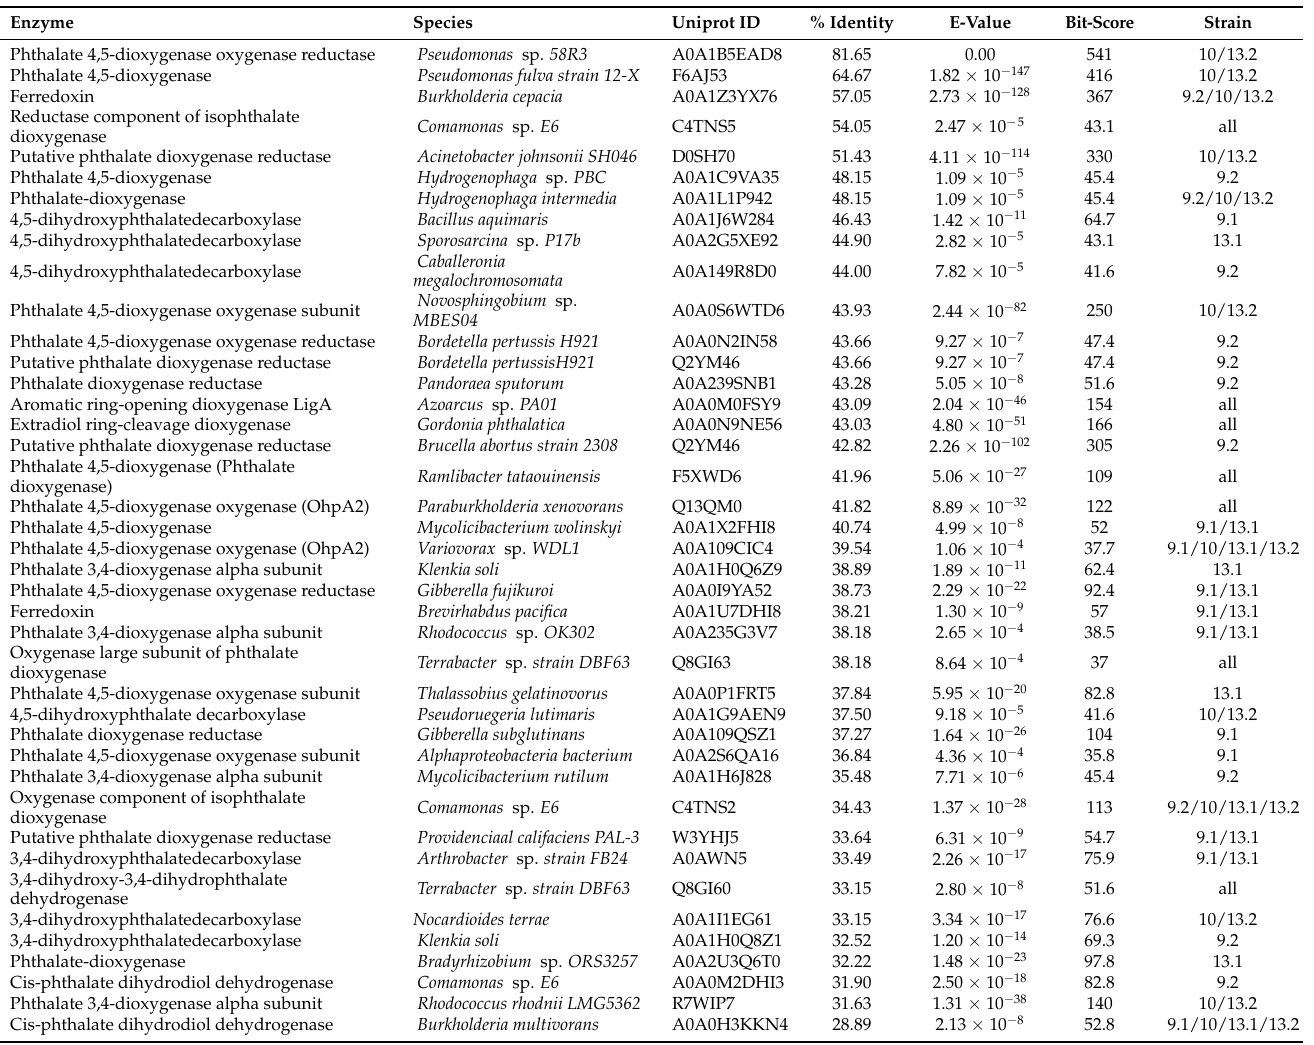
Table 3. Predicted phthalate plasticizer biodegradation genes with significant percentage identity and similarity to genes encoded in strains within the full